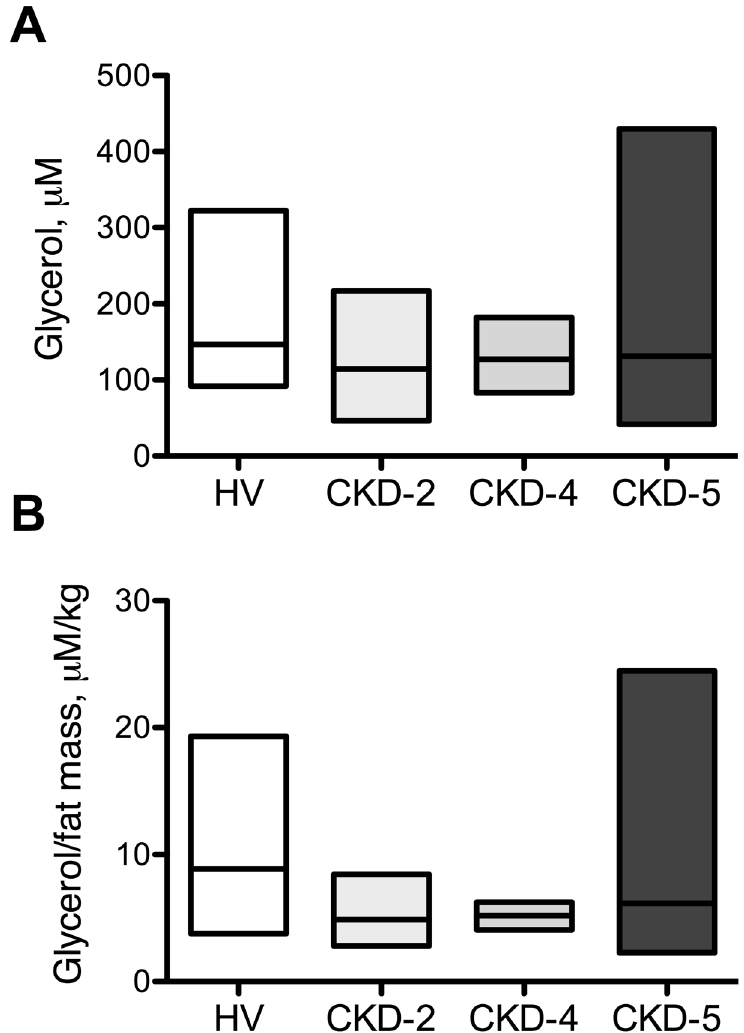
Figure 4. Plasma glycerol concentration in non-CKD and CKD patients. Plasma glycerol was measured as an index of lipolysis in 17 non-CKD patients, 6 CKD-2, 4 CKD-4 and 12 CKD-5 patients. A) plasma glycerol concentration B) Plasma glycerol, concentration normalized to body fat mass as described in methods. No difference was found to be significant at the P , 0.05 level using Kruskall & Wallis test.